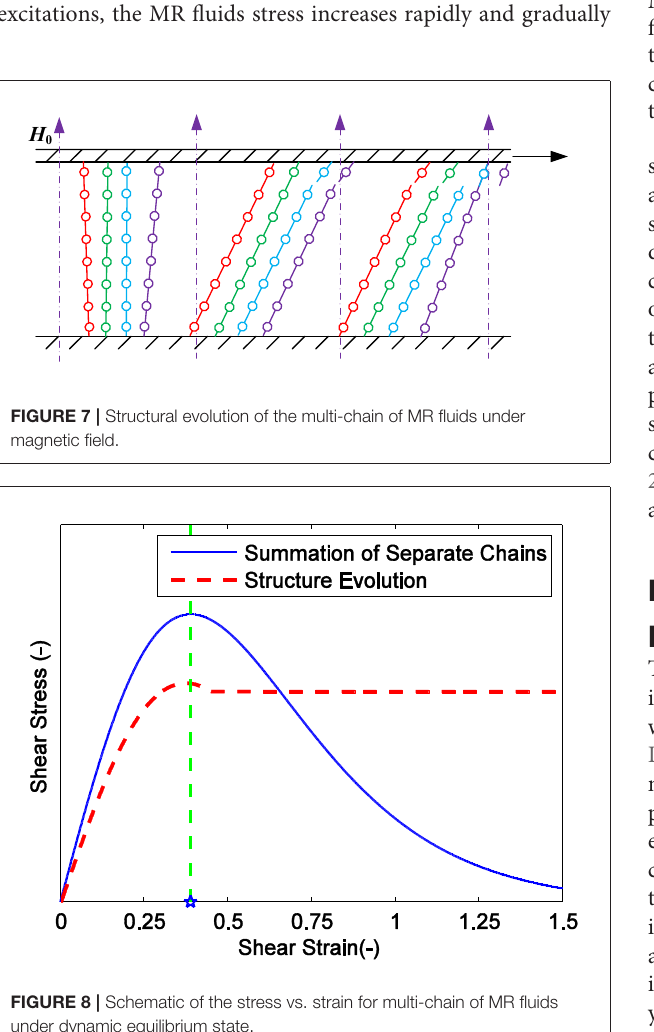
FIGURE 8 | Schematic of the stress vs. strain for multi-chain of MR fluids under dynamic equilibrium